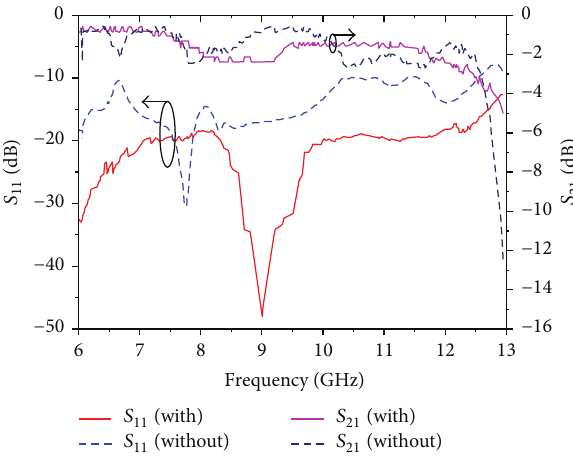
Figure 11: 𝑆 -parameter of the right angle transition.